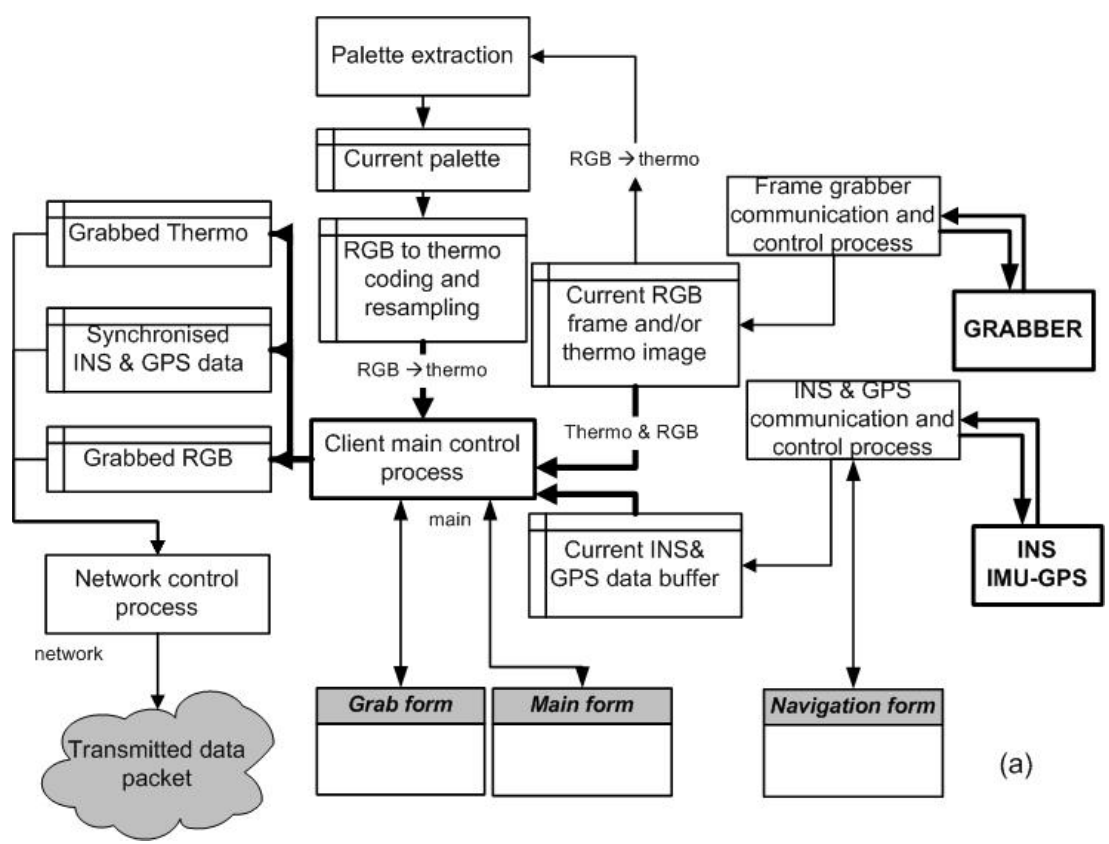
Figure 6 . (a) S/W operations for sensor control and input raw data processing; (b) operations applied on the server PC station for data package decoding, image thresholding, and image